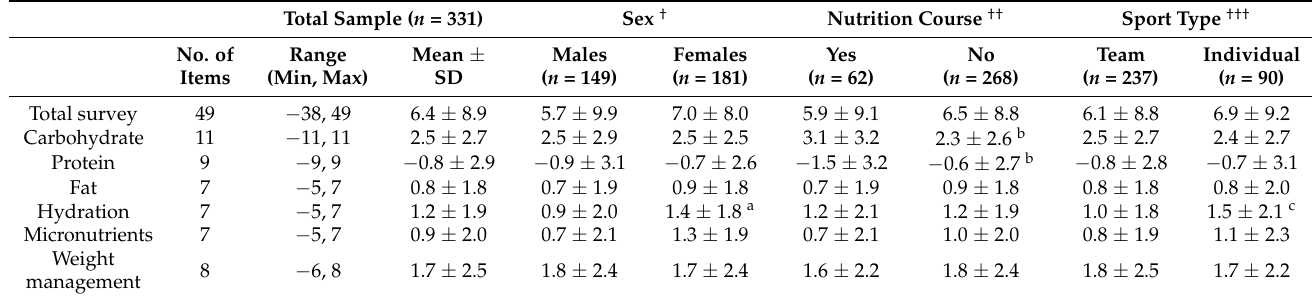
Table 2. Athlete sport nutrition knowledge